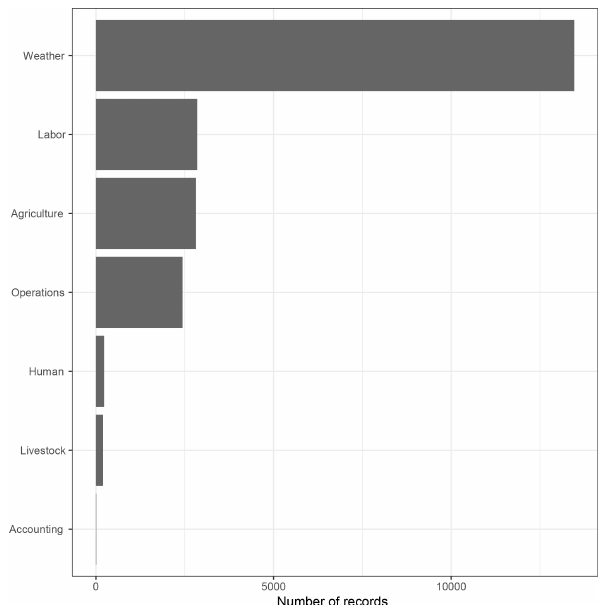
Figure 5. Entry type by observation category. The most common entry was about the weather, followed by agriculture, operations, and labor. Other categories had many fewer